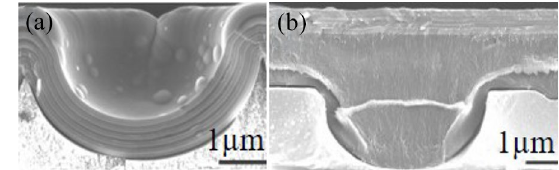
Figure 15 SEM images of the holes covered by conformal multilayer stacks of 11 alternating layers of titanium and alumina: a Method 1 cross-sectional view; b Method 2 cross-sectional view